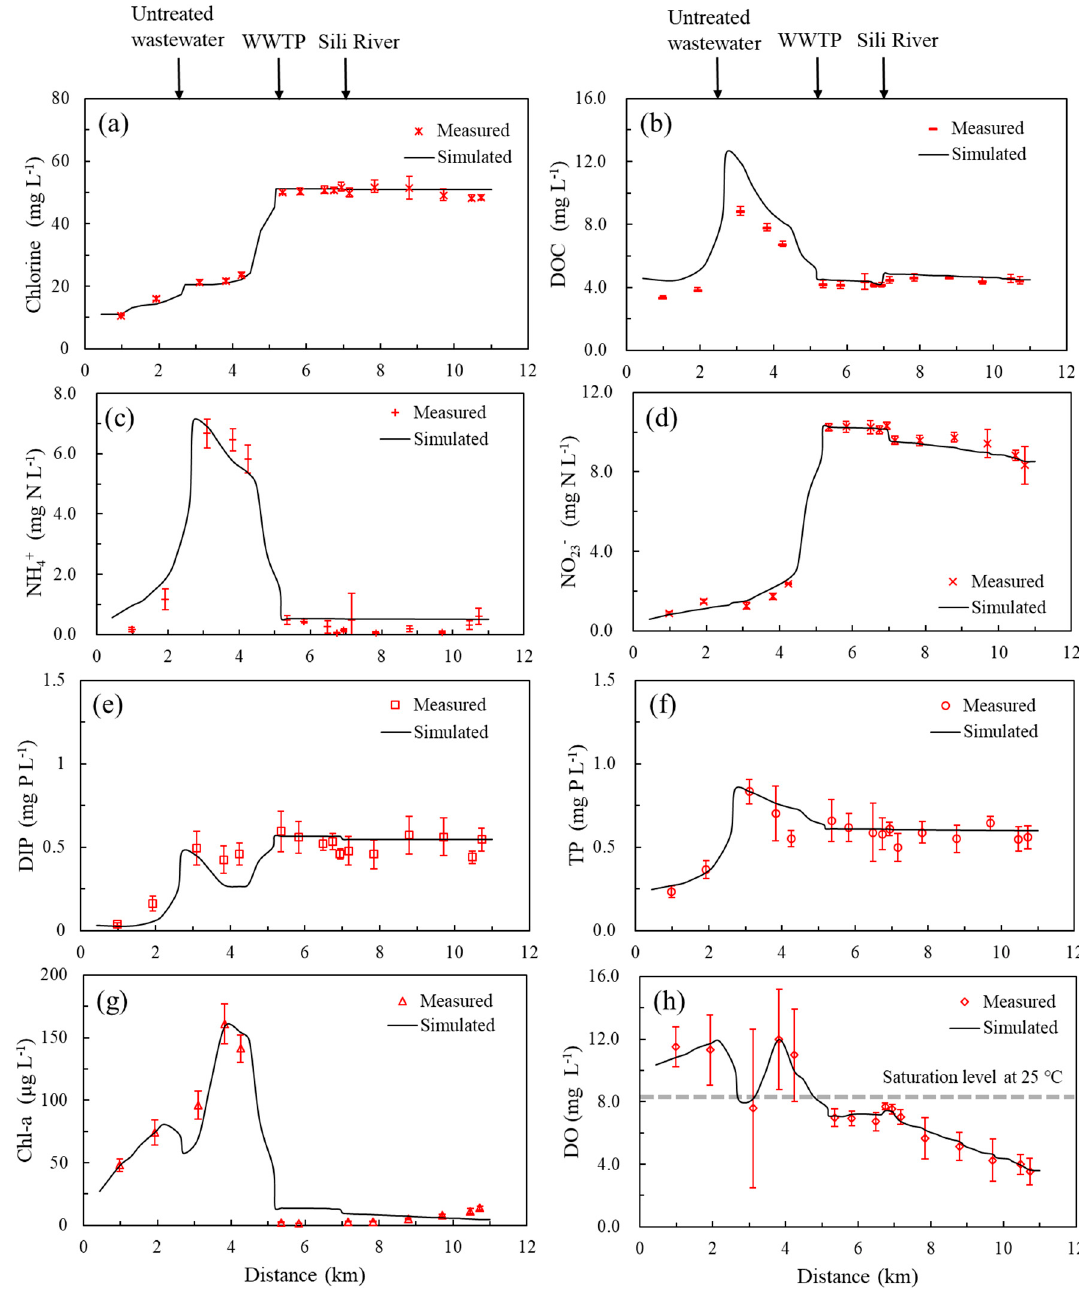
Figure 5. Measured and simulated concentrations of the related water quality constituents. ( a ) Cl − ; ( b ) DOC; ( c ) NH 4+ ; ( d ) sum of NO 2- and NO 3- ; ( e ) DIP; ( f ) TP; ( g ) Chl-a and ( h ) DO. Error bars represent standard deviations of bi-hourly observed data. Grey dash line in panel ( h ) represents DO saturation level at 25 °C. Table 2. Stoichiometric and kinetic parameters related to DO balance in the model.